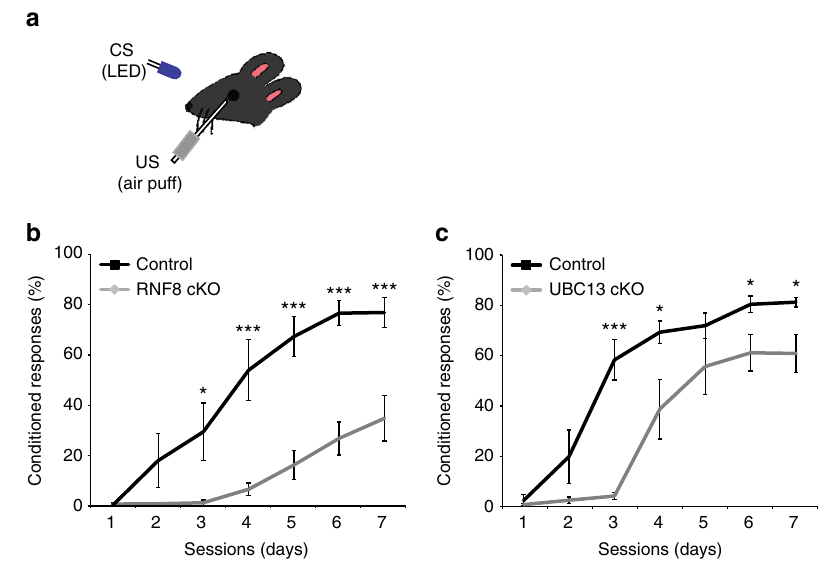
Fig. 7 Cerebellar-dependent learning is impaired in RNF8 or UBC13 conditional knockout mice. a Schematic of delayed eye-blink conditioning assay depicting a mouse trained with a conditioned stimulus (CS: blue LED) paired with an eyeblink-eliciting unconditioned stimulus (US: periocular air puff). Depletion of RNF8 ( b) or UBC13 ( c ) impaired performance on the eye-blink conditioning task (*** p < 0.005, * p < 0.05, ANOVA followed by Fisher ’ s PLSD post hoc